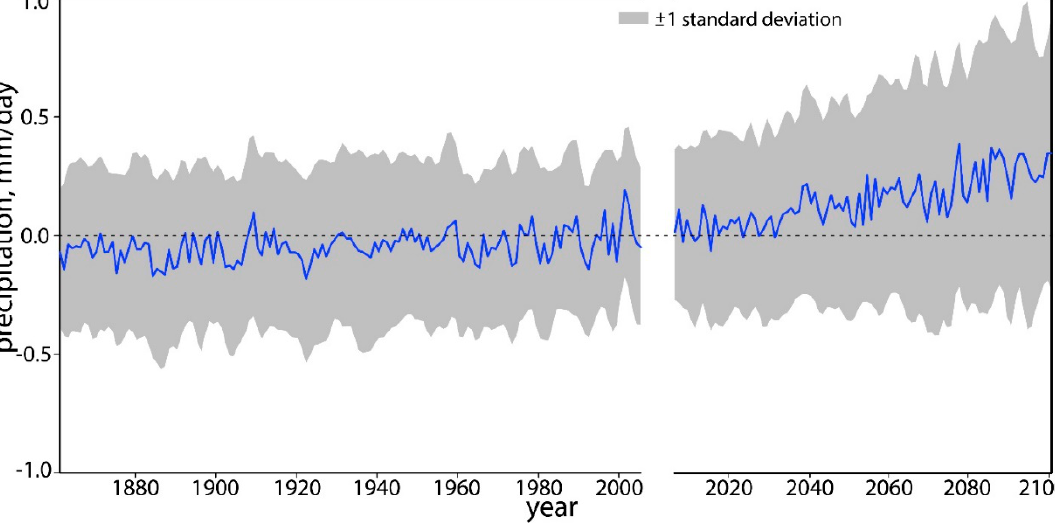
Figure 7. Annual average Coupled Model Intercomparison Project (CMIP) precipitation over Tanzania (2–12S, 30–40E) from CMIP5 simulation. Data from all 44 members are considered to calculate the average precipitation (blue line) and shaded area shows the ± 1 standard deviation calculated from all members. Anomalies in mm/day are calculated based on the average value from 1971–2000.